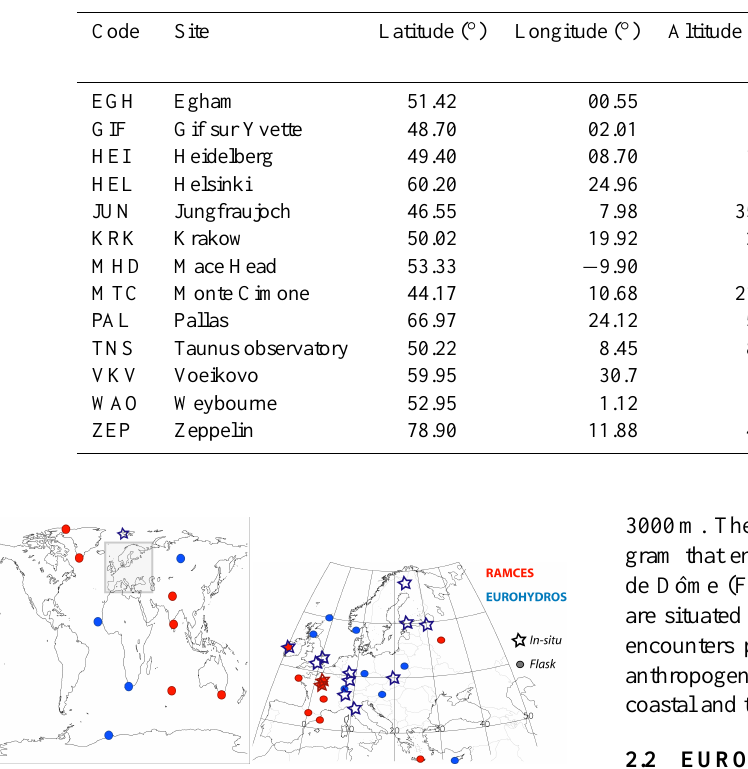
Table 2. EUROHYDROS continuous stations. AGH-UST: University of Science and Technology, Poland; EMPA: Swiss Federal Institut for